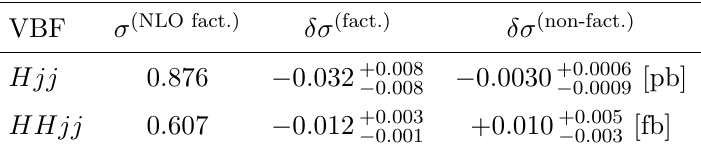
Table 2. Fiducial cross sections for single and double Higgs VBF production at NLO, along with the corresponding NNLO corrections. The quoted uncertainties correspond to scale dependence, while statistical errors at NNLO are about 0 : 5 . For details on the scale variation see sec h